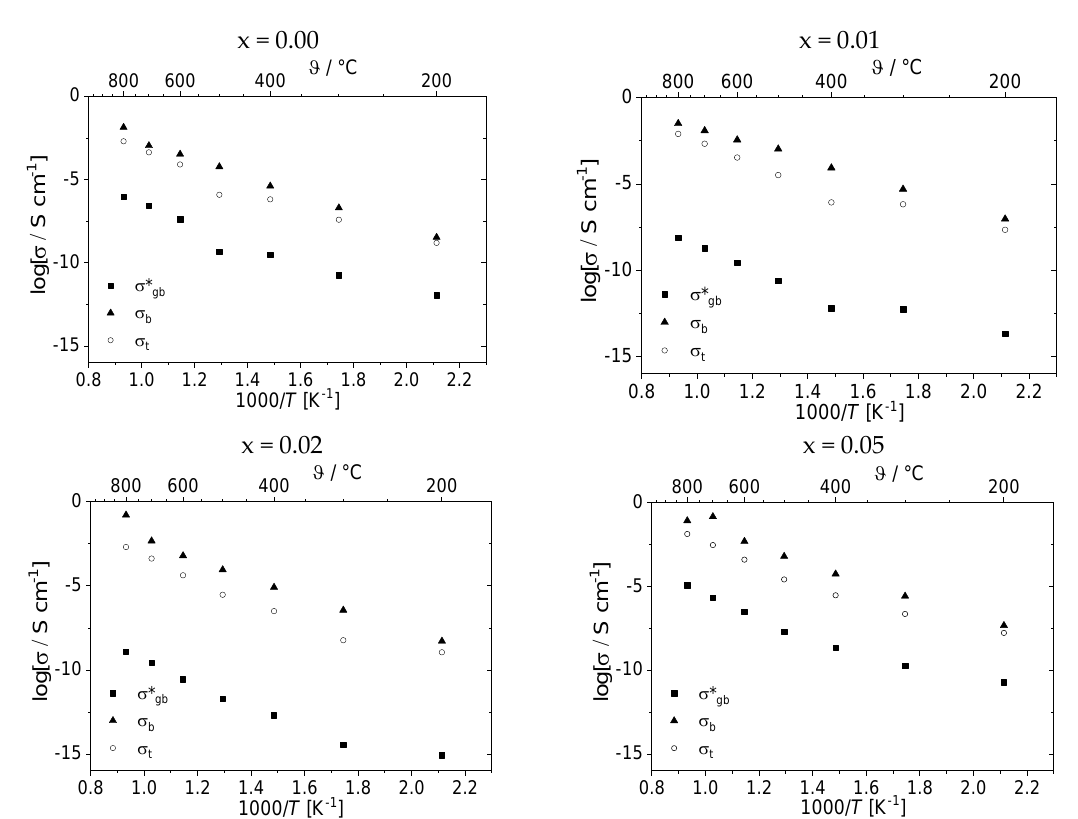
Figure 4. Grain boundary, grain, and electrical conductivity from impedance spectroscopy Figure 4.